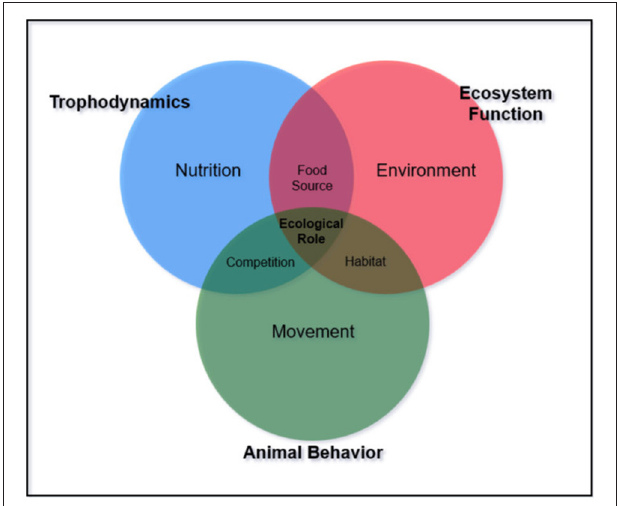
FIGURE 1 | Diagram of how necessary concepts contribute to informing ecological roles of a species.